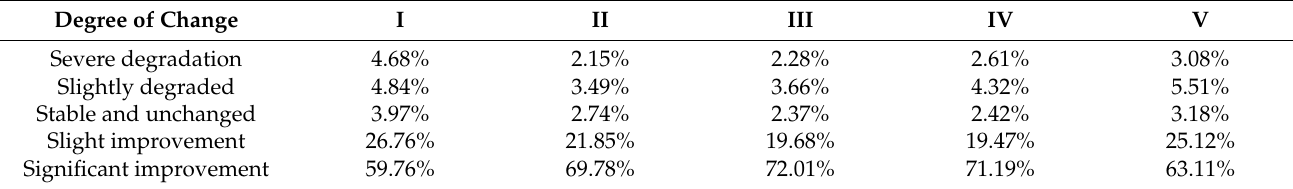
Table 2. Changes of NDVI in the Lancang River Basin.